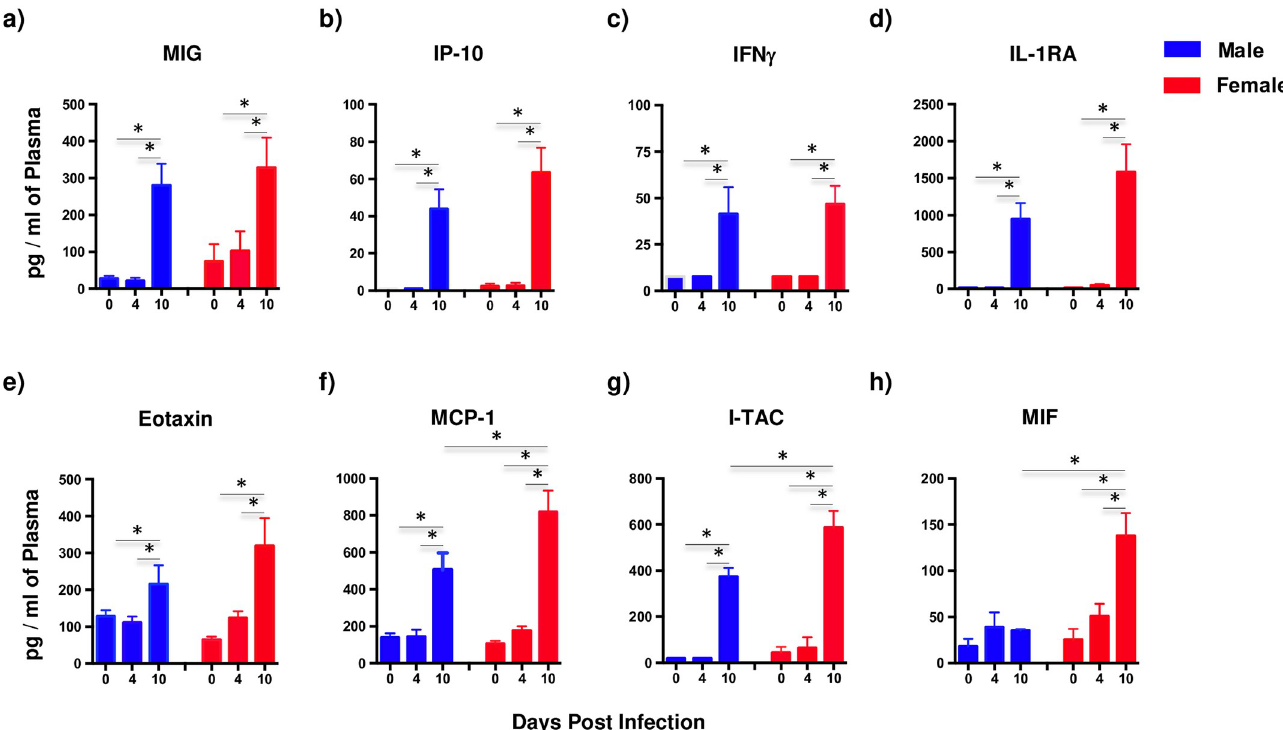
Fig 4. Plasma levels of MCP-1, I-TAC and MIF are significantly upregulated in female macaques as compared to male macaques during acute SIV infection. Levels of (a) MIG, (b) IP-10, (c) IFN γ , (d) IL-1RA, (e) Eotaxin, (f) MCP-1, (g) I-TAC, and (h) MIF in the plasma samples that were collected from each animal at day 0, 4 and 10 post-SIV infection from male (n = 4) and female (n = 4) macaques. Error bars represent standard error.